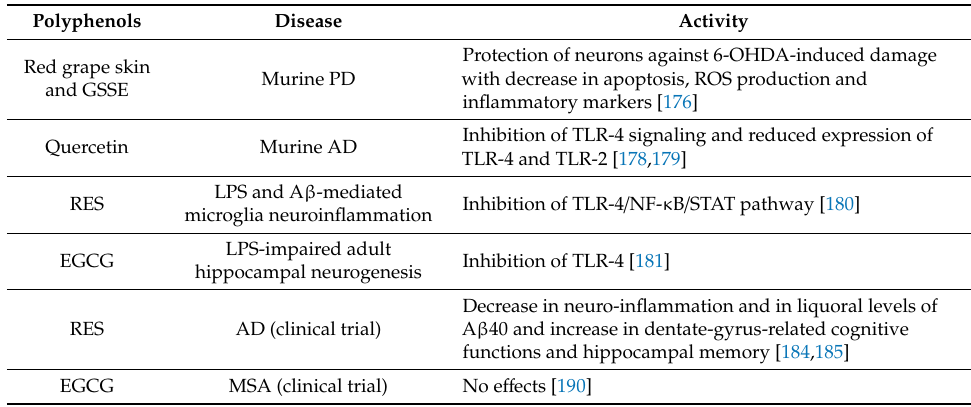
Table 5. E ff ects of red grape polyphenols on